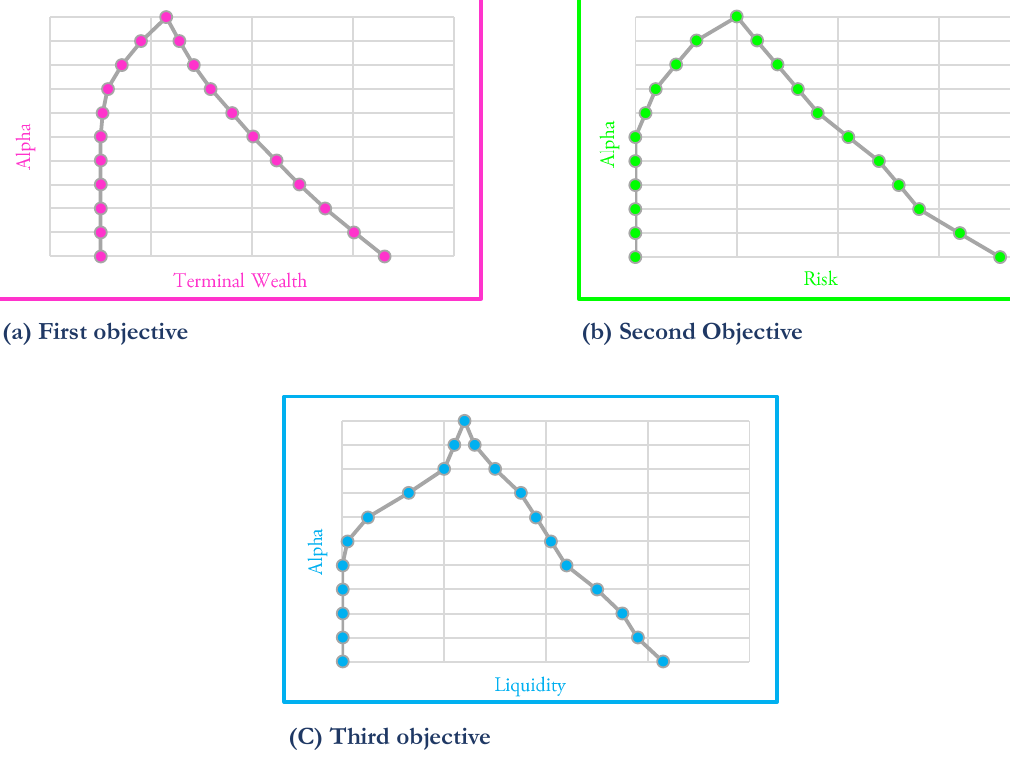
Fig. 2. The presentation of objective functions under different